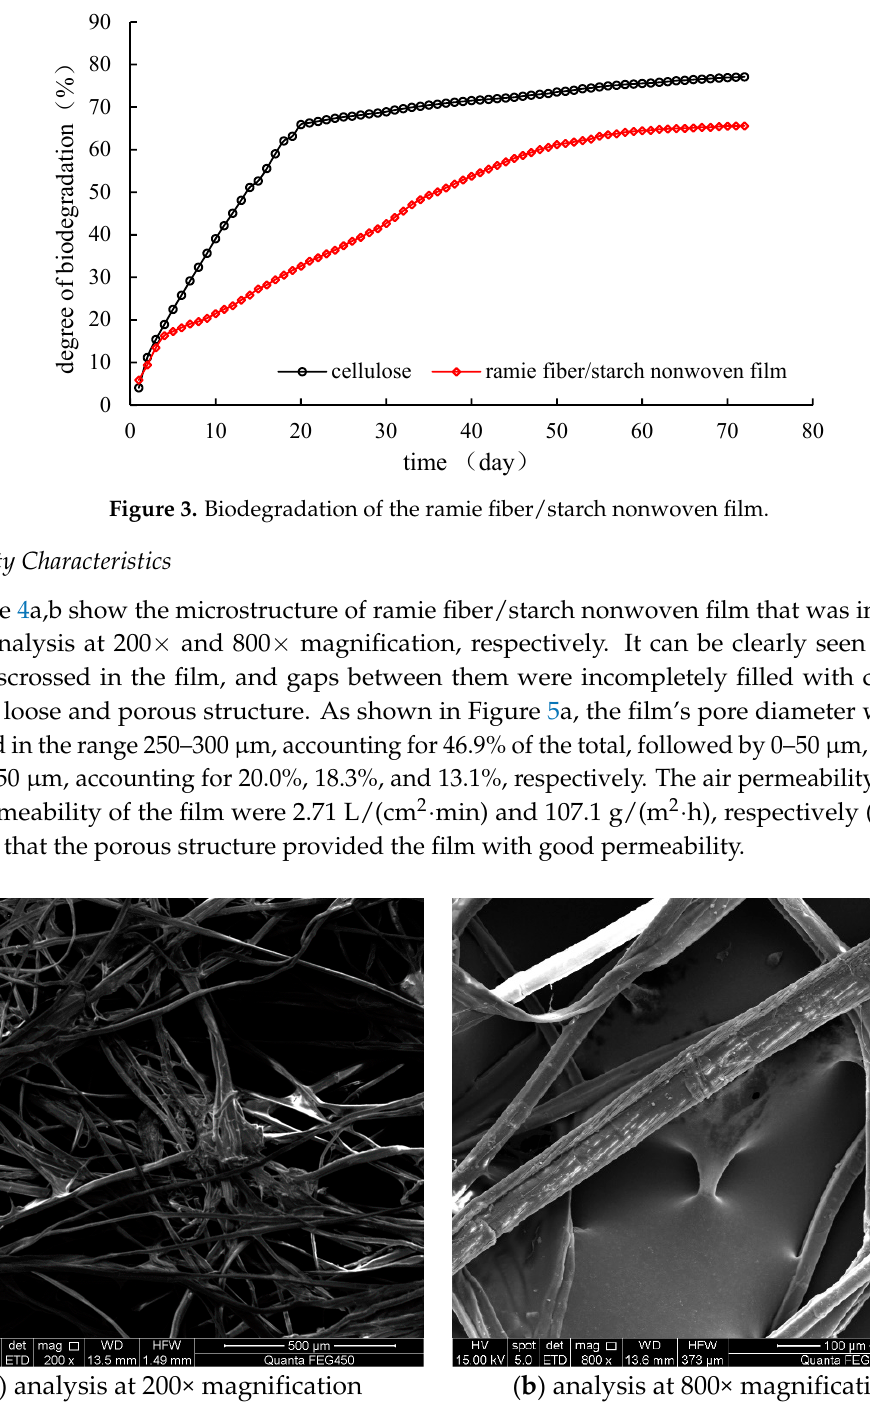
Figure 4. Scanning electron microscopy (SEM) pictures of the ramie fiber/starch nonwoven film.